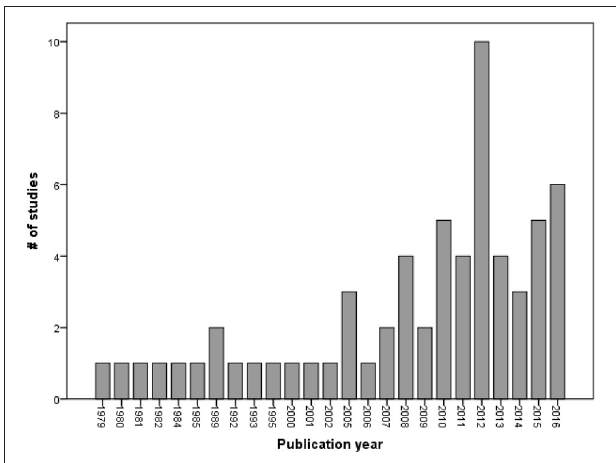
FIGURE 1 | Number of published studies per year between 1979 and